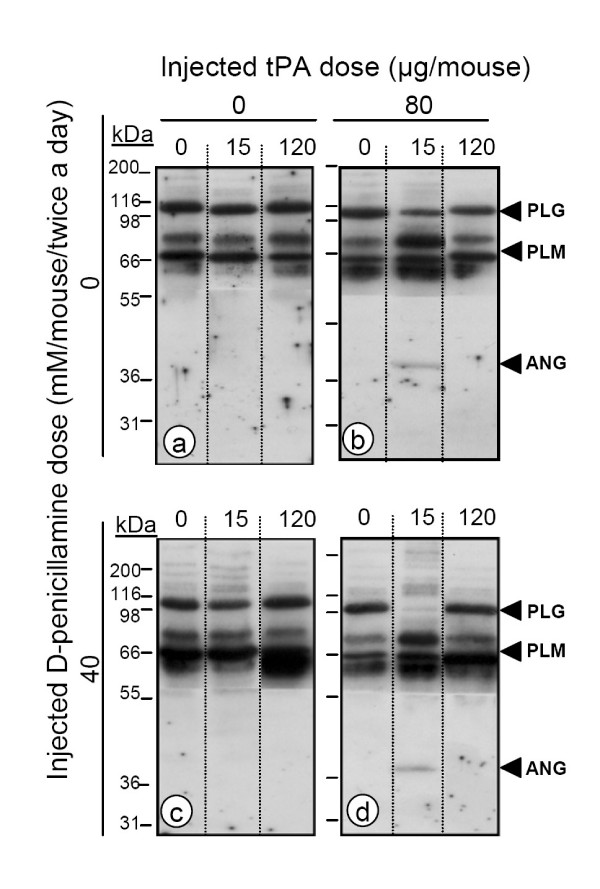
In vivo angiostatin formation in healthy mice after treatment with tPA and/or D-penicillamine. In vivo angiostatin generation was induced by administration of tPA (two i.v. injections, on day 3 and 7) and/or D-penicillamine (i.p. injection, twice daily, starting prior to the first tPA injection) to healthy BALB/c mice. Plasma samples were collected prior to the tPA injection on day 7 (t = 0), and 15 or 120 minutes after tPA injection. After purification by lysine sepharose affinity chromatography, samples were analyzed on western blot. Note a complete conversion of plasminogen to plasmin, and the formation of angiostatin in mice receiving tPA and D-penicillamine, 15 minutes after tPA injection.